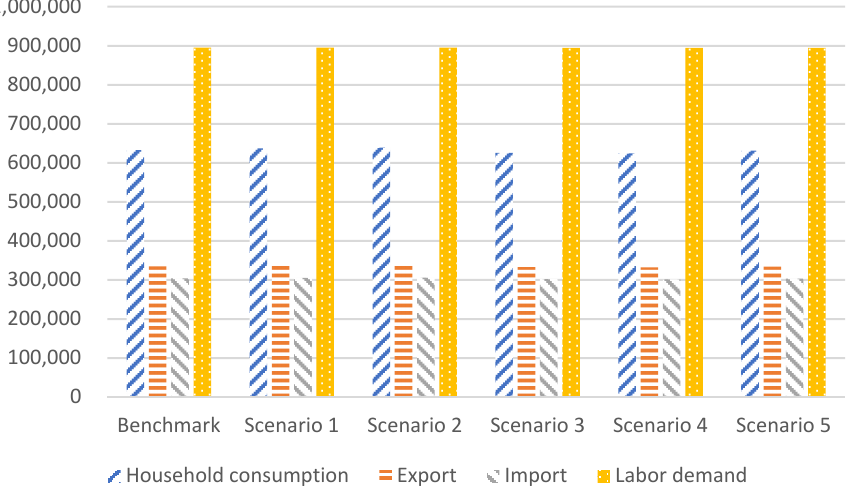
Figure 7. Change in major macro variables in China in 2030 under different scenarios (100 million RMB).